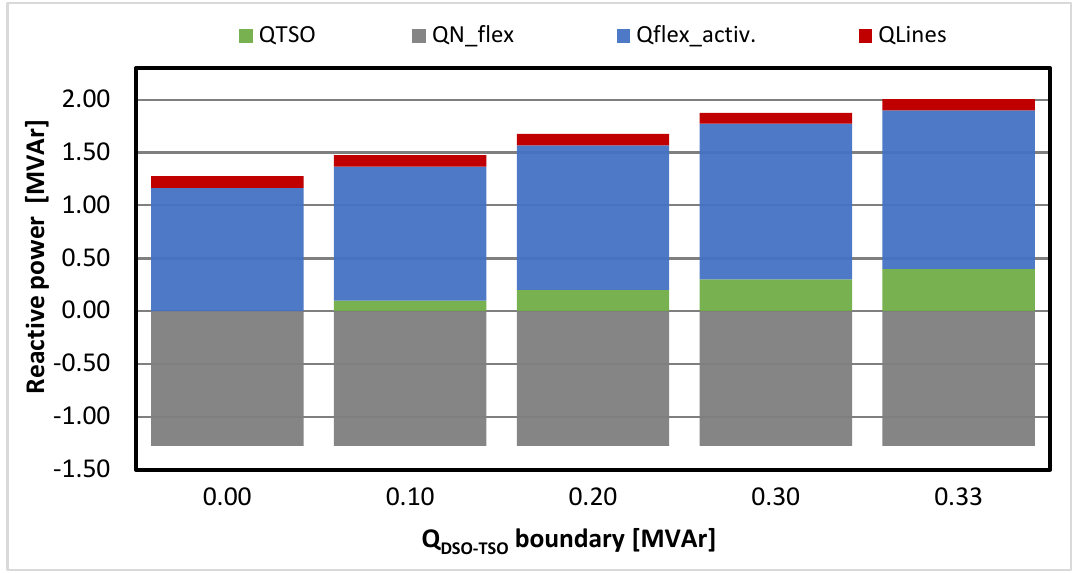
Figure 15. Reactive power components for increasing TSO Q capacitive needs.